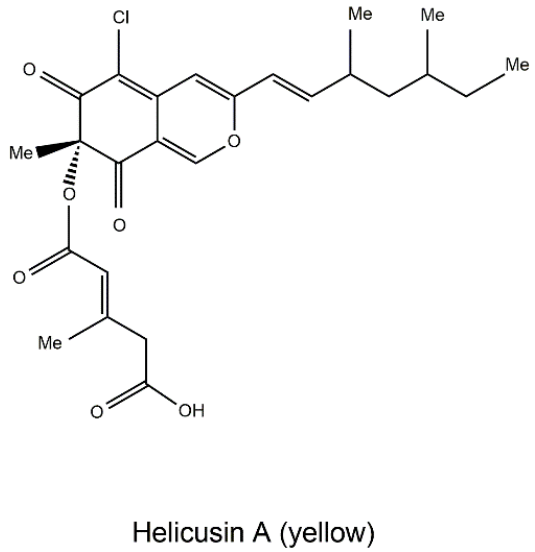
Figure 12. Structure of helicusin A, a pigment from marine fungus Bartalinia robillardoides .